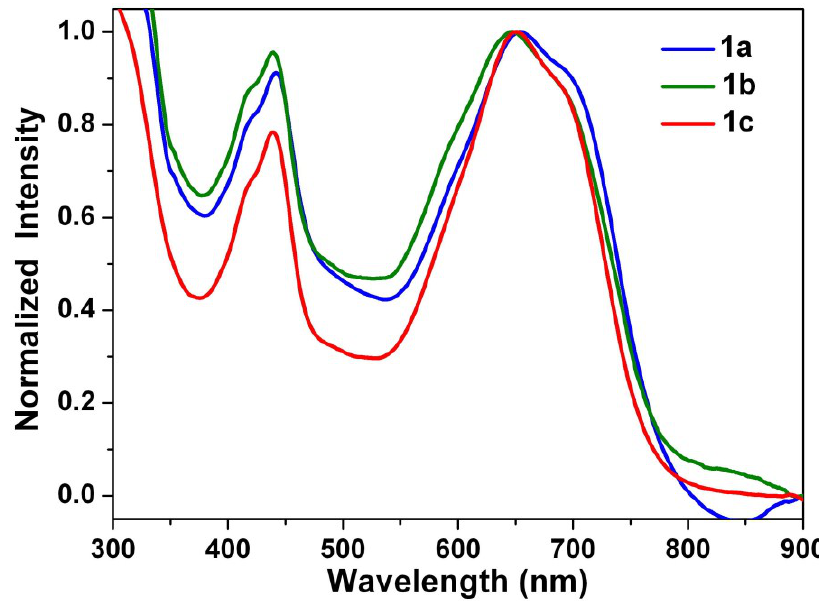
Figure 9. Normalized absorption spectra of 1a – 1c in neat